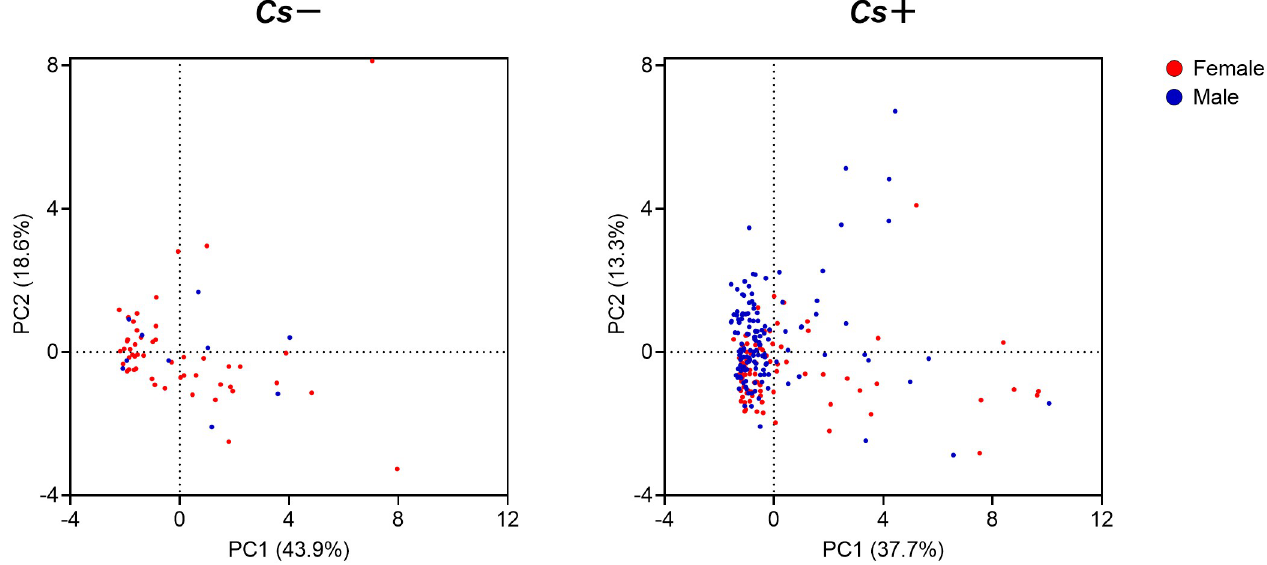
Fig 5. Principle component analysis (PCA) plots of anti-CsAWA specific antibodies and cytokines from Cs - and Cs + individuals. The PCA stands for the two principal components of variation. Left panel, Cs - individuals (n = 50 in female and n = 10 in male). Right panel, Cs + individuals (n = 91 in female and n = 138 in male). Cs : C . sinensis